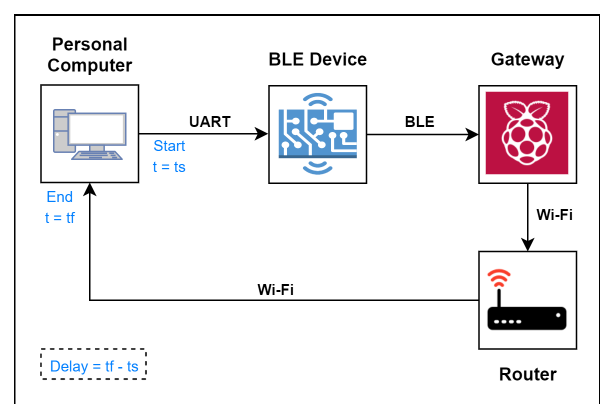
Figure 5. Method used to measure the communication delay for each packet.